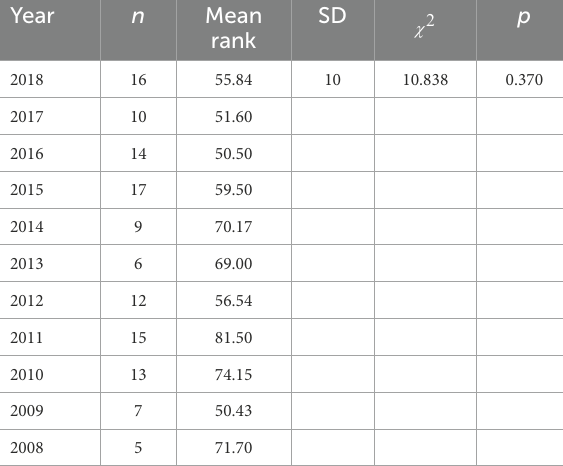
TABLE 4 H-Test results of similarity indexes of postgraduate theses in Austria grouped by year.